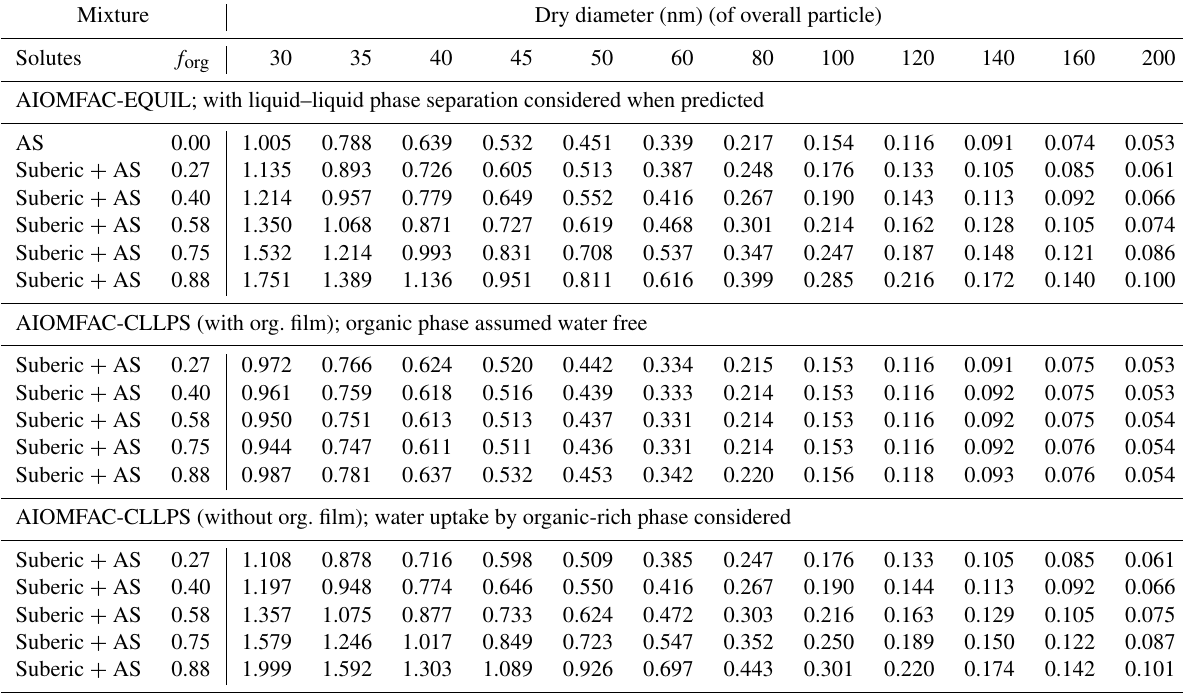
Table 2. Critical supersaturation SS crit (%) for given dry diameters ( D dry , crit ) and organic volume fractions ( f org ) in dry particles at T = 293 . 15K; predicted by the different AIOMFAC-based models.